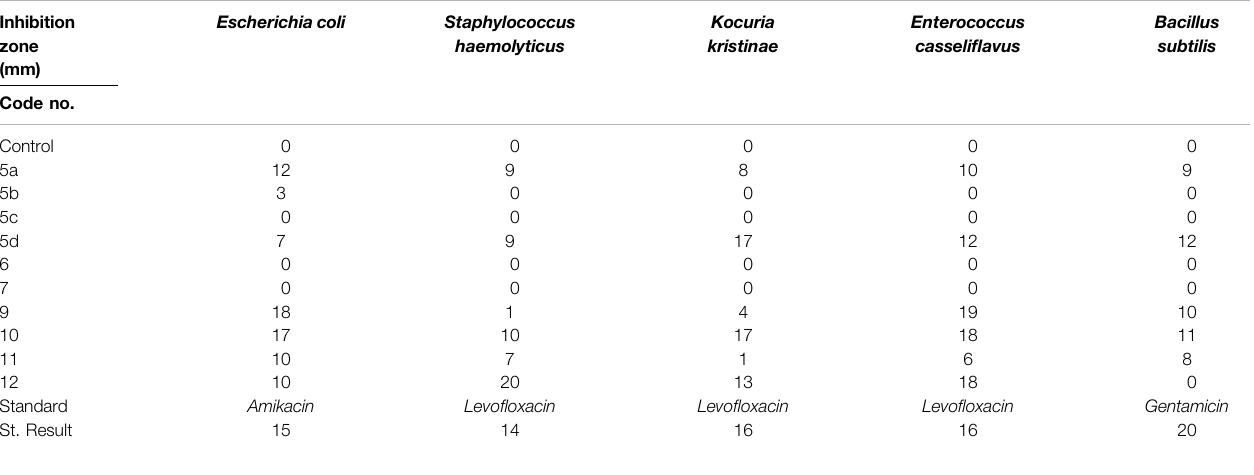
TABLE 2 | Antibacterial activity of the screened compounds 5 – 12 . Inhibition zone (mm) Code